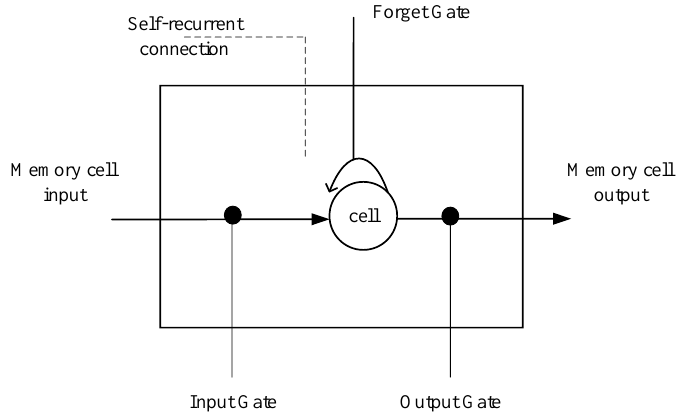
Figure 2. Internal structure of LSTM neuron.